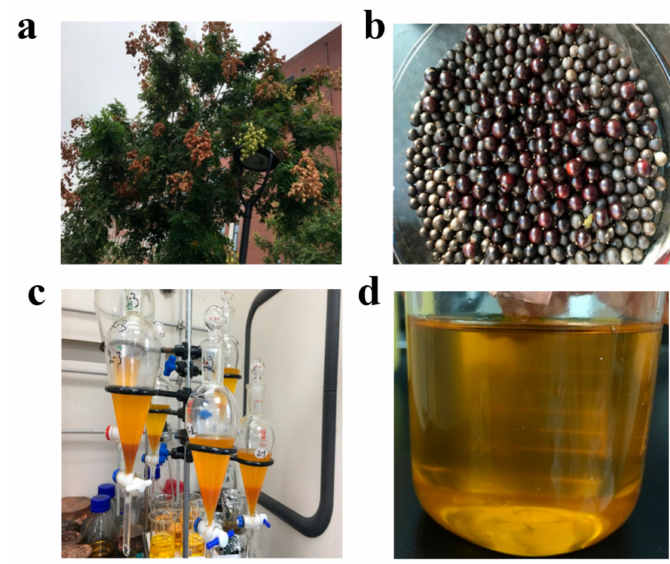
Figure 2. ( a ) Koelreuteria paniculata plant (KP) ( b ) KP seed ( c ) Transesterification (the process of optimization) ( d ) Pure KP biodiesel after